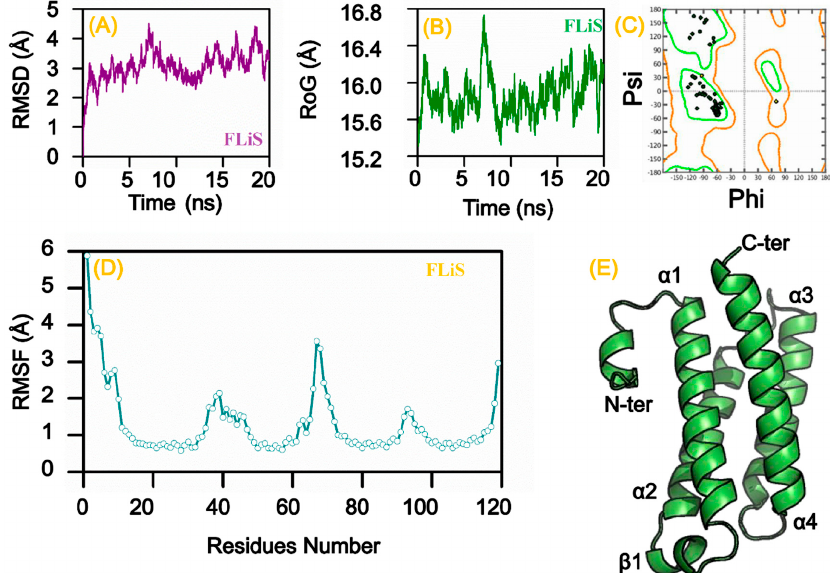
Figure 6. Molecular dynamics simulation for vaccine target (FLiS protein) ( B. burgdorferi B31). Root Mean Square Deviation (RMSD) ( A ). Radius of Gyration (RoG) ( B ). Validation by Ramachandran plot ( C ). Root Mean Square Fluctuation (RMSF) ( D ). Tertiary structure prediction ( E ).